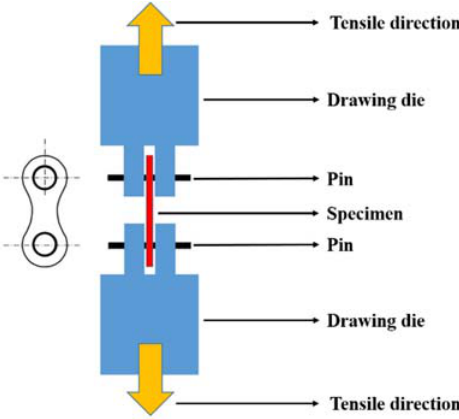
Figure 7. The schematic diagram of the tensile test method.